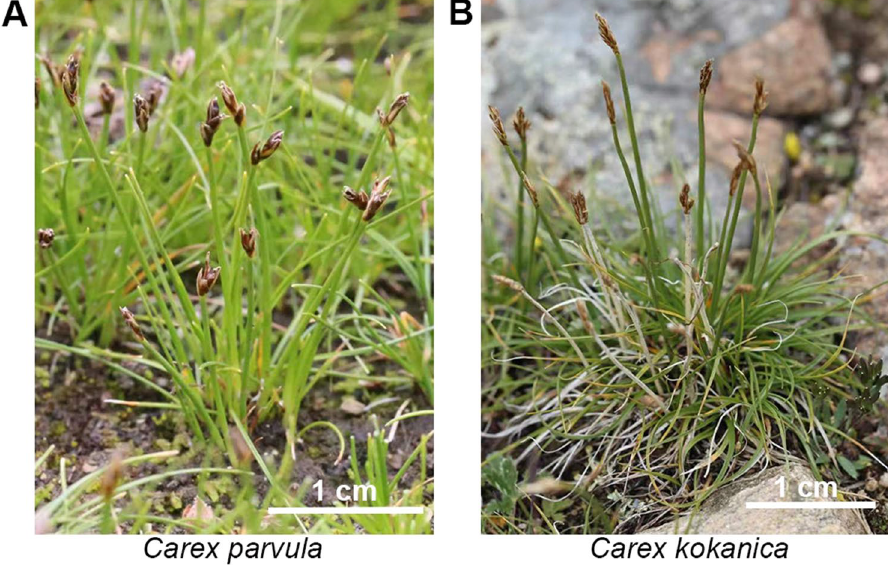
Figure 1. The Carex parvula and Carex kokanica used in this study. ( A ) The C. parvula individual. White bar = 1 cm. ( B ) The C. kokanica individual. White bar = 1